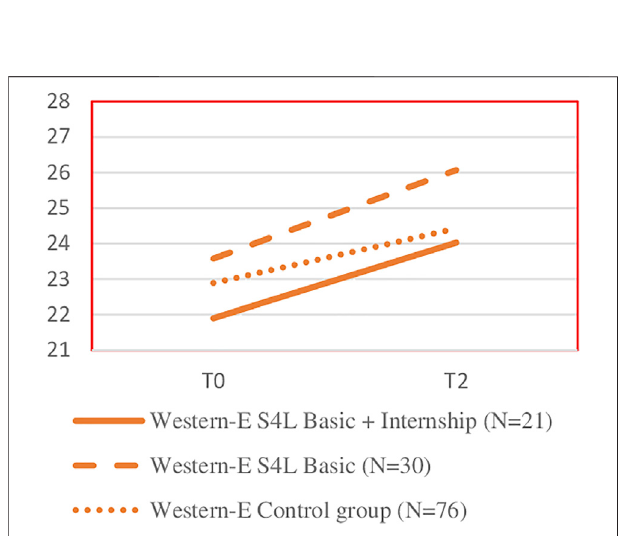
FIGURE 3 | Relationship skills T0 – T2 skills Western-E students (Means) Note: Western-E (cid:1) Students who identify themselves as having western background (e.g., Dutch, Belgium or German) S4L-basc + internship (cid:1) Students exposed to the S4L-basic and the S4L-intership module; S4L-basic (cid:1) Students exposed to the S4L-basic module alone; Control group (cid:1) Students in the Waitlist Control group.